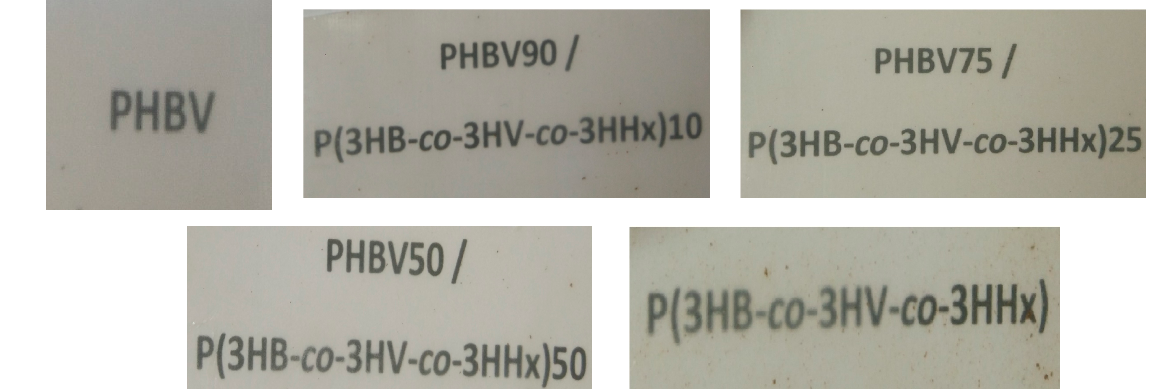
Figure 2. Contact transparency images of the thermo-compressed films of poly(3-hydroxybutyrate- co -3-hydroxyvalerate) (PHBV), poly(3-hydroxybutyrate- co -3-hydroxyvalerate- co -3-hydroxyhexanoate) [P(3HB- co -3HV- co -3HHx)], and their blends. To quantify the color change resulting from the addition of P(3HB- co -3HV- co -3HHx) to PHBV, the color coordinates (a*, b*, L*) and the values of ∆ E*, T, and O were determined and reported in Table 2. From this, it can be observed that all the film samples presented similar values for the a*, b* and L* coordinates, with a tendency to green and yellow color,